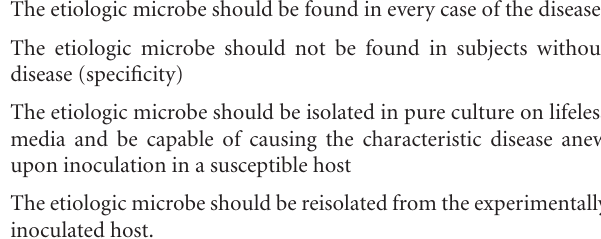
Table 1: Koch’s postulates [1].